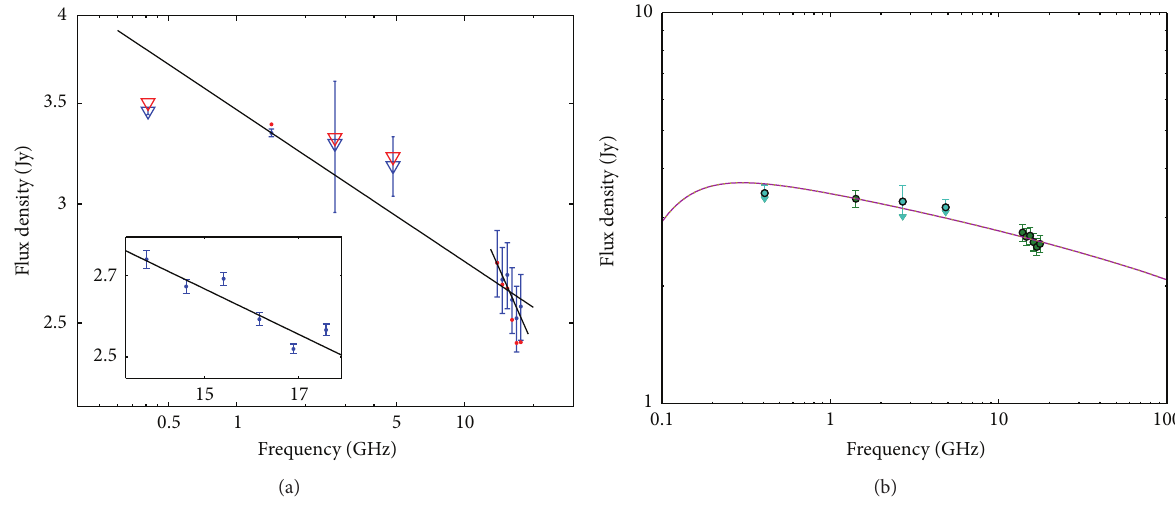
Figure 2: SED for AME-G173.6+2.8, including flux densities at 0.408 and 1.42GHz from the CGPSE catalogue, 2.7 GHz from Effelsberg, and 4.85 GHz from the GB6 catalogue corrected by the flux loss percentage of the AMI channel 3 observation and the flux-loss-corrected AMI fluxes. (a) shows flux densities corrected using the sampled CGPS map (blue) and using a simulated Gaussian source as a consistency check (red). Lower resolution flux densities are shown as triangles as they are considered to be upper limits. Also shown are the spectral index fits to CGPS 1.42GHz and AMI together and to the blue AMI points separately. The inset plot is zoomed in to the AMI flux densities; here the errors plotted are the JMFIT error estimates only (without calibration uncertainty). (b) shows a free-free spectrum fit to the flux densities (see text for